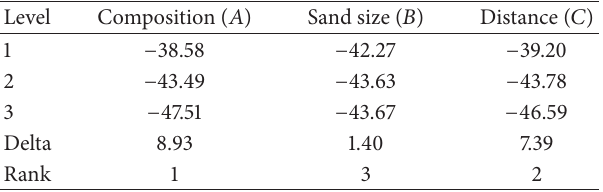
Table 8: Response data for 𝑆 / 𝑁 ratios under three-body